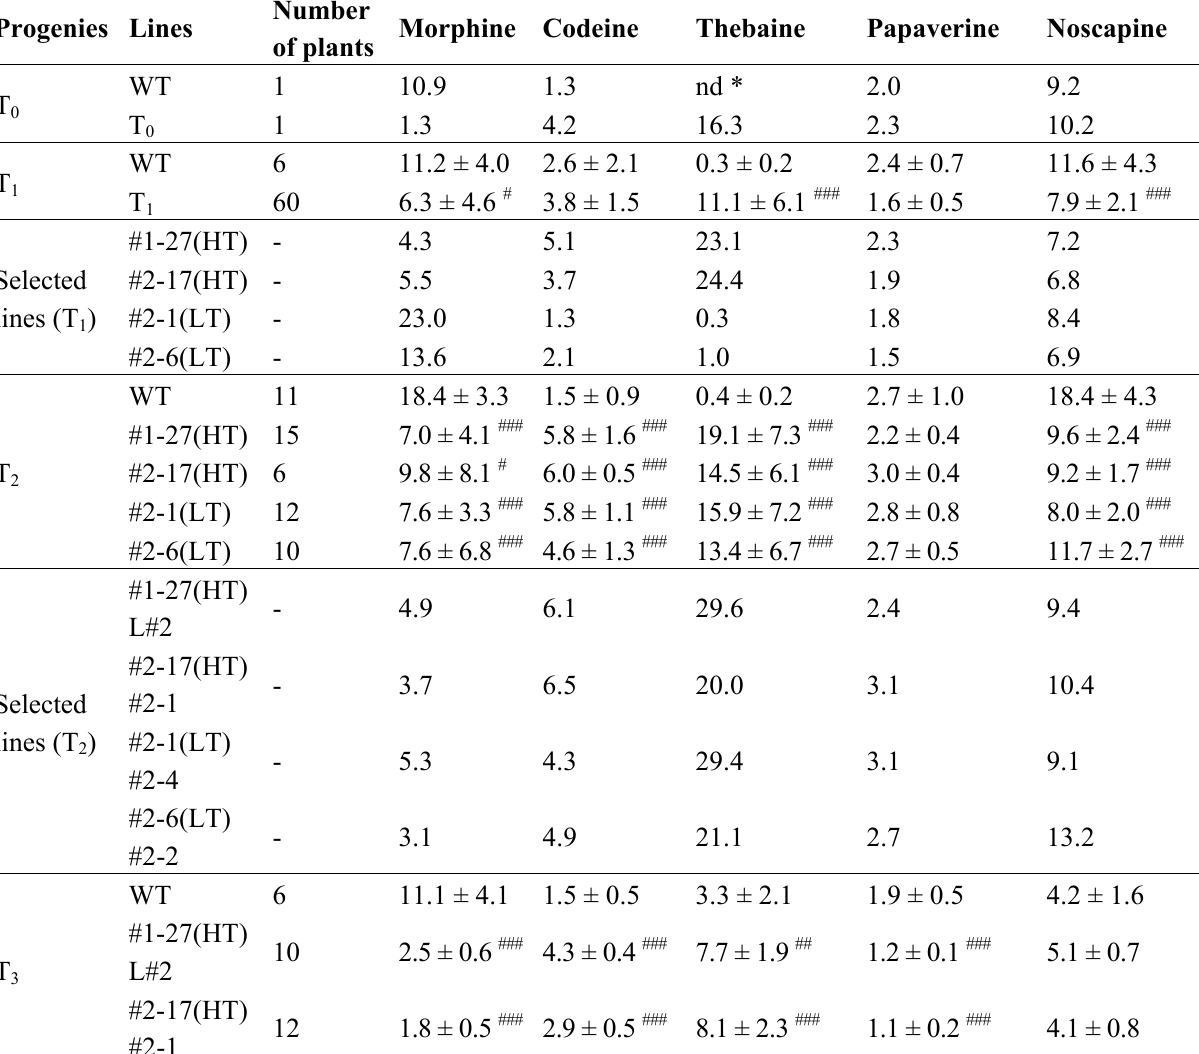
mutant and selfed progenies. 0